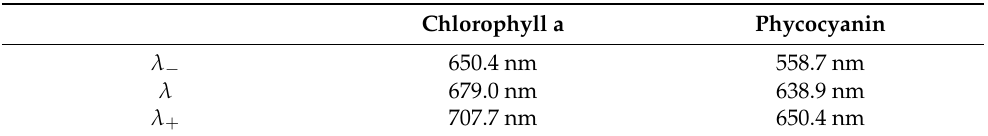
Table 1. HICO bands chosen for the detection of chlorophyll a and phycocyanin through the spectral shape. (Data source: